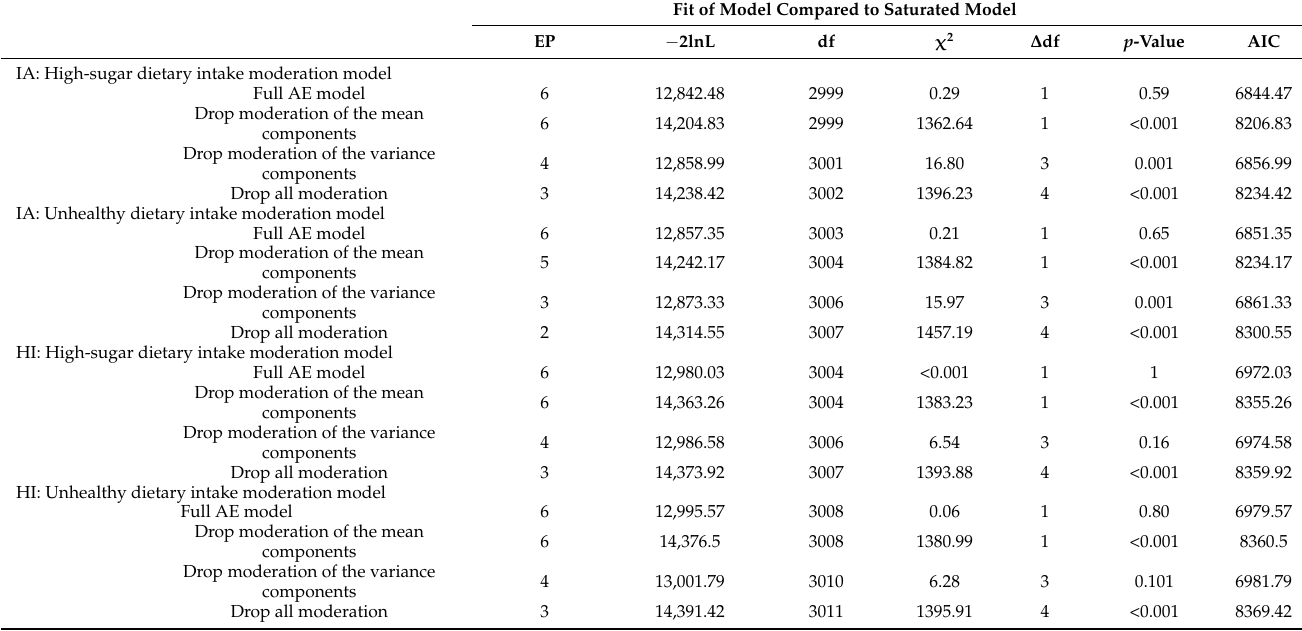
Table 3. Model-fitting results of moderation models with 95% confidence intervals and dietary